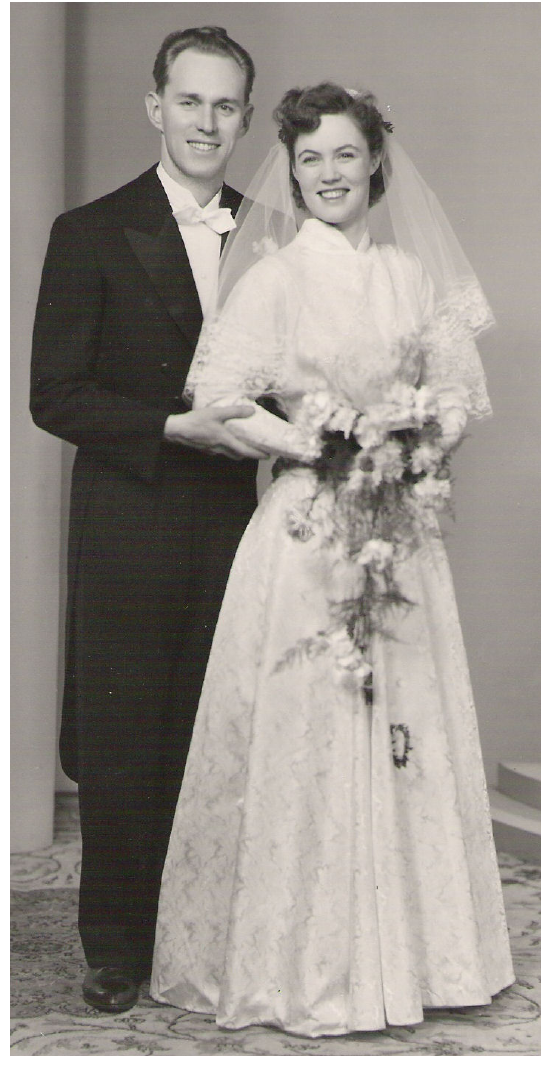
Figure 17: A happily married young couple in 1956.